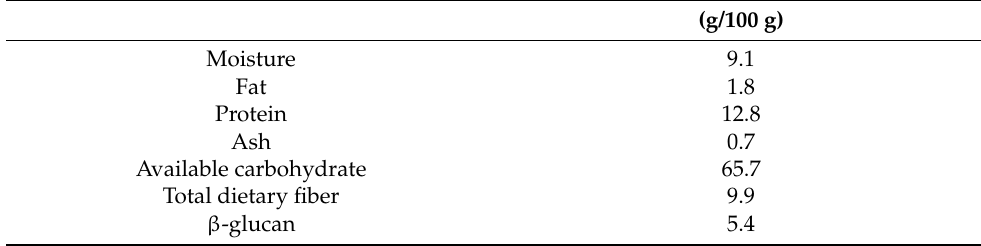
Table 1. Nutritional components of high β -glucan barley